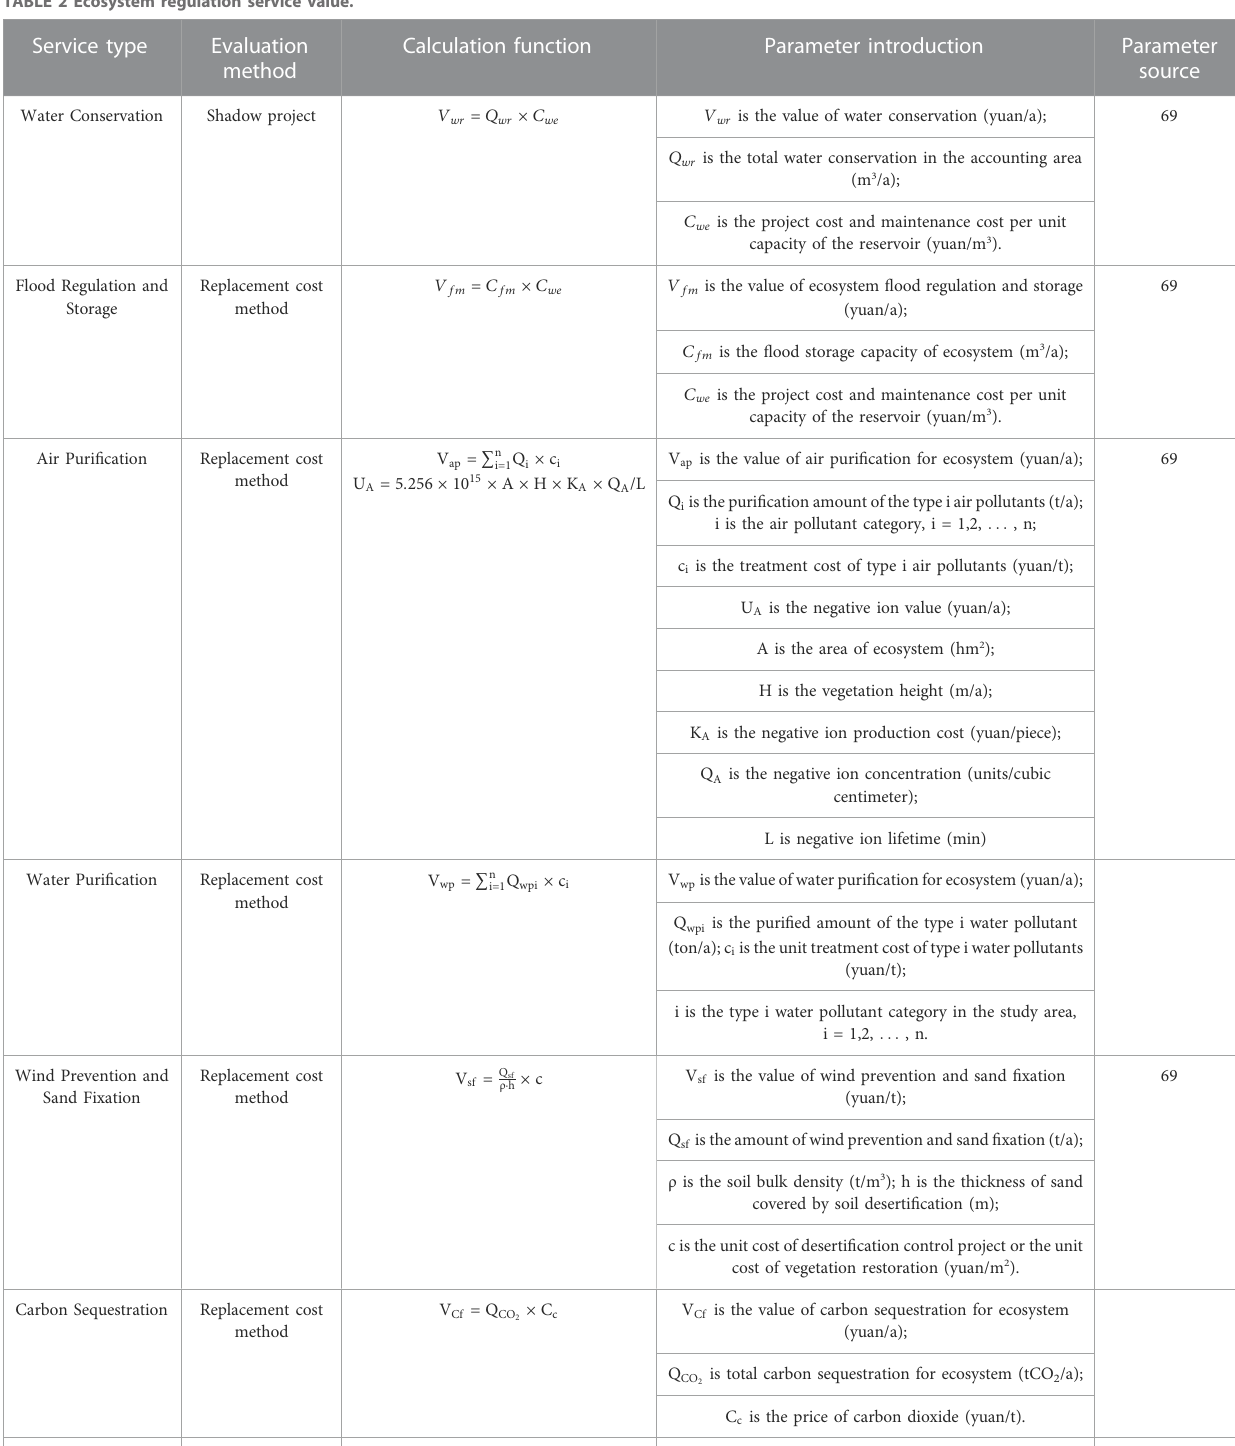
TABLE 2 Ecosystem regulation service